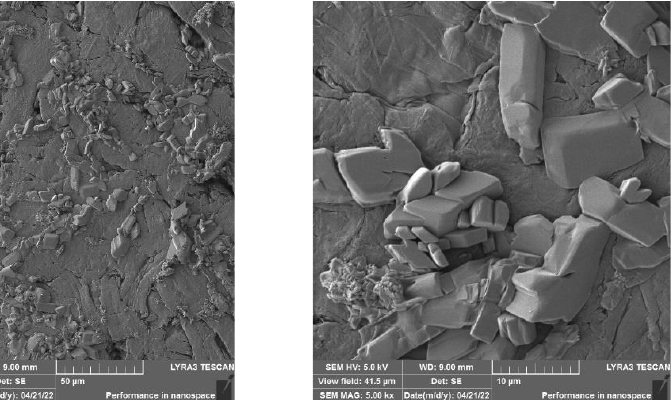
Figure6. Maximum MX release flux depending on carrier surface coverage by MX for planar surface impregnated by 8 mg/mL MX solution ( ■ ) compared to the flux from reference 100% MX tablet surface ( ▲ ).